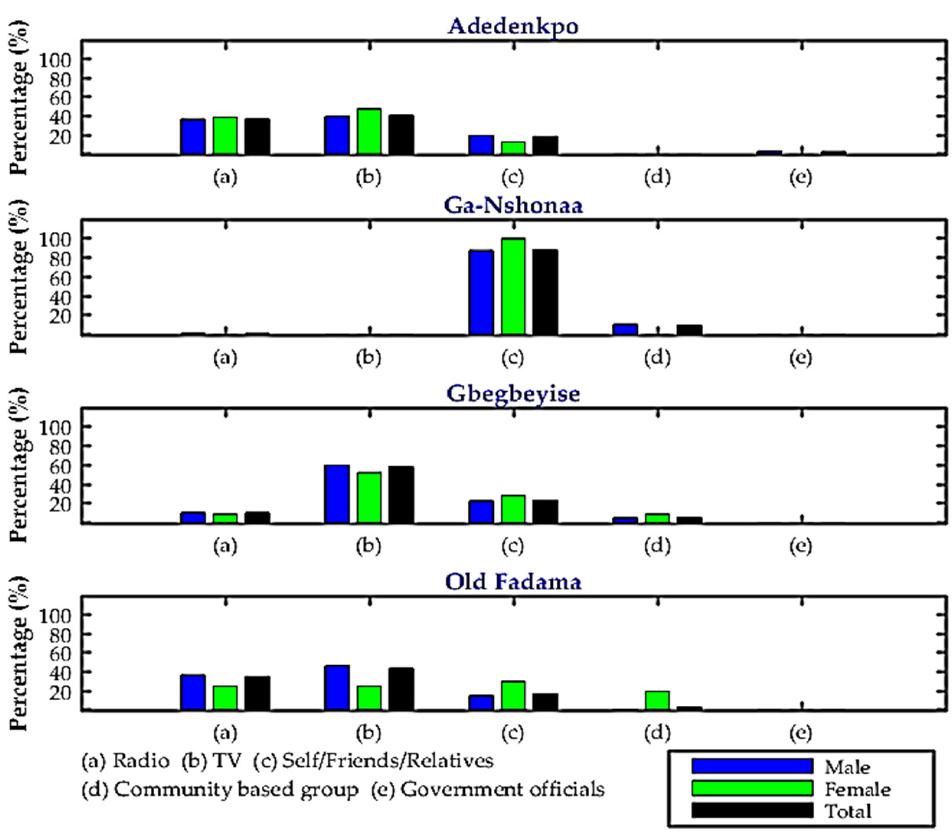
Figure 6. Percentage of Main Source of Early Warning over the Last 1–2 years. Source: Authors’ construct, based on household survey.